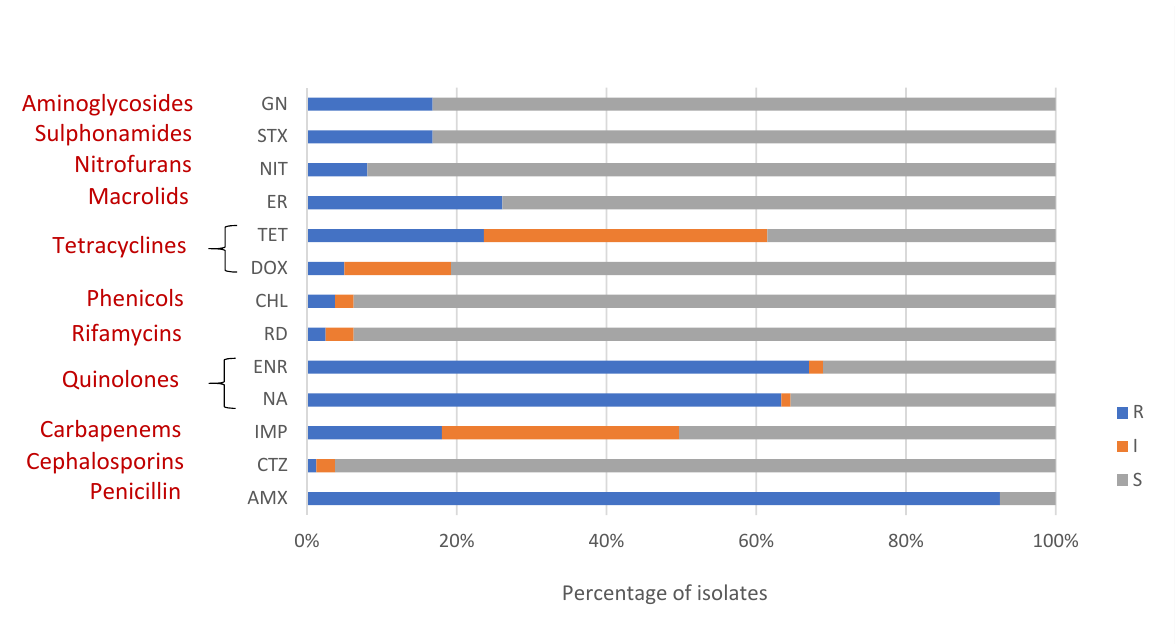
Figure 3. Antimicrobial susceptibility patterns of 161 Aeromonas isolates for antimicrobials tested and their classes (in dark red); amoxicillin (AMX), nalidixic acid (NA), enrofloxacin (ENR), rifampicin (RD), chloramphenicol (CHL), doxycycline (DOX), tetracycline (TET), erythromycin (ER), nitrofurantoin (NIT), trimethoprim-sulfamethoxazole (STX), gentamicin (GN), ceftazidime (CTZ) and imipenem (IMP) are shown. (R—resistant, I—intermediate, S—susceptible).